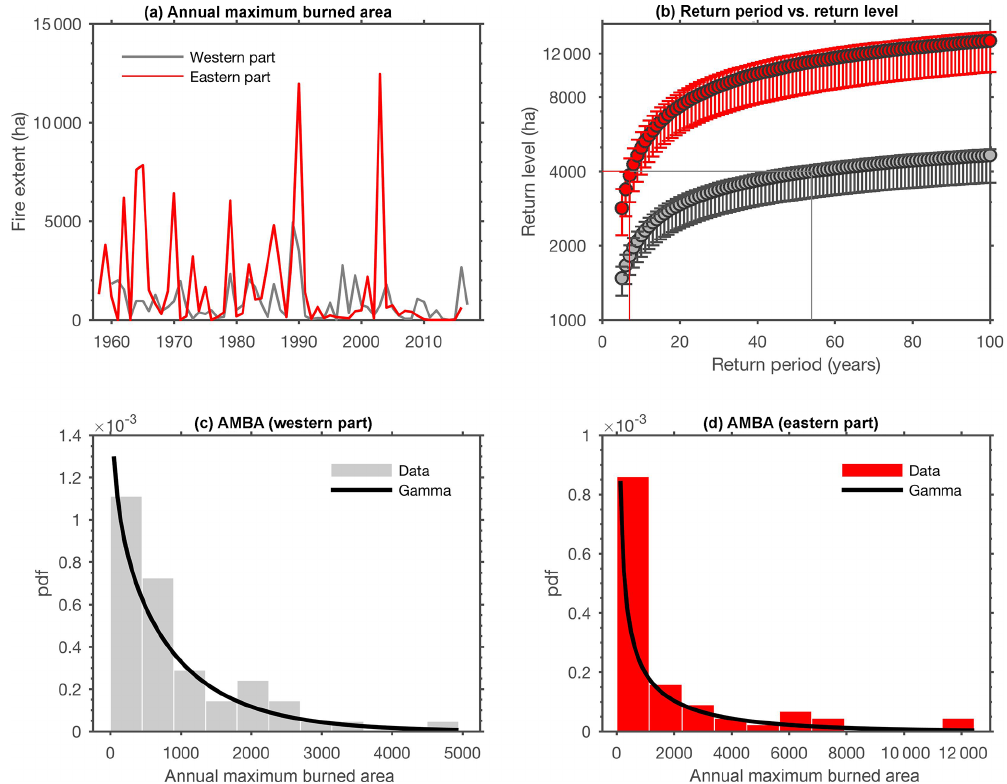
Figure 6. (a) Time series of the annual maximum burned area (AMBA) in the western part (in gray) and in the eastern part (in red). (b) Return levels in AMBA in the western part (in gray) and in the eastern part (in red) for different return periods ranging from 5 to 100 years. The 95% confidence intervals were estimated using a bootstrapping approach. (c) Distribution of AMBA in the western part (bars) with the gamma distribution (black line) that was found to best describe the data. (d) Same as (c) but for the eastern